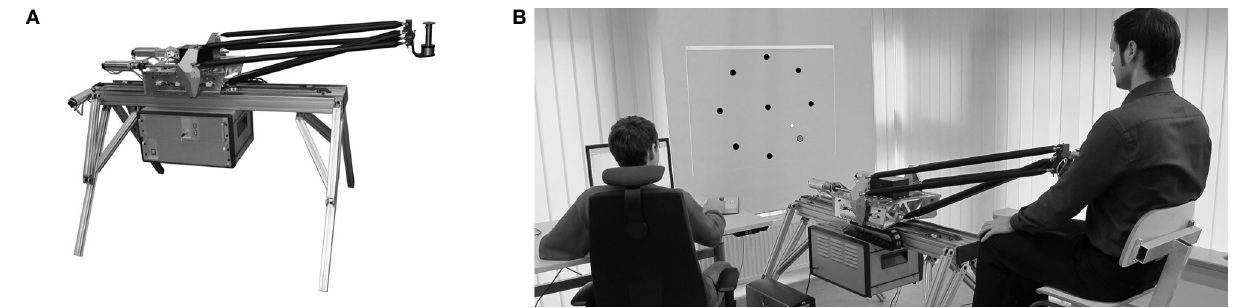
FIGURE 1 | (A) Robotic device BioMotionBot. (B) Subject performing the horizontal point-to-point reaching task. The cursor corresponding to the position of the handle and the targets were displayed on a screen facing the